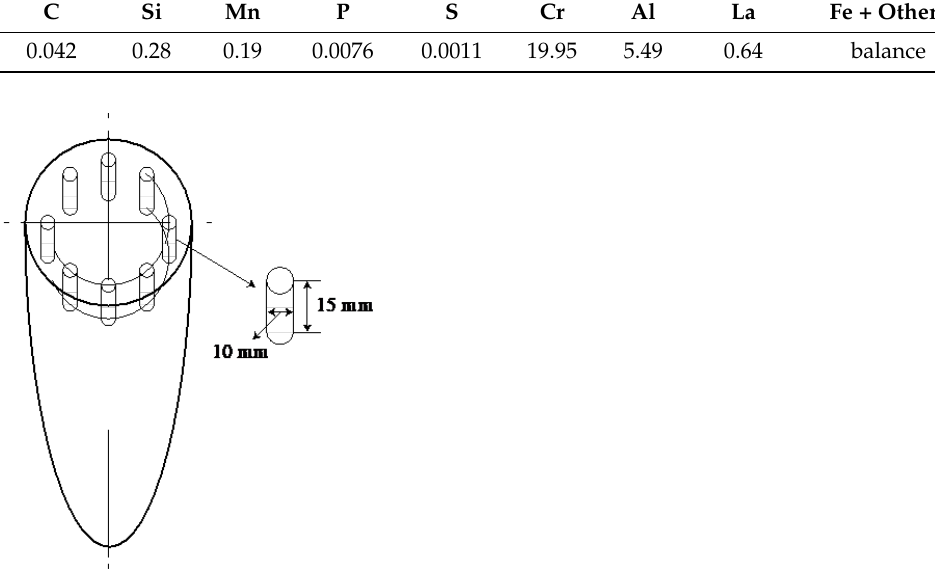
Figure 1. Schematic diagram of the sampling method for isothermal compression tests.